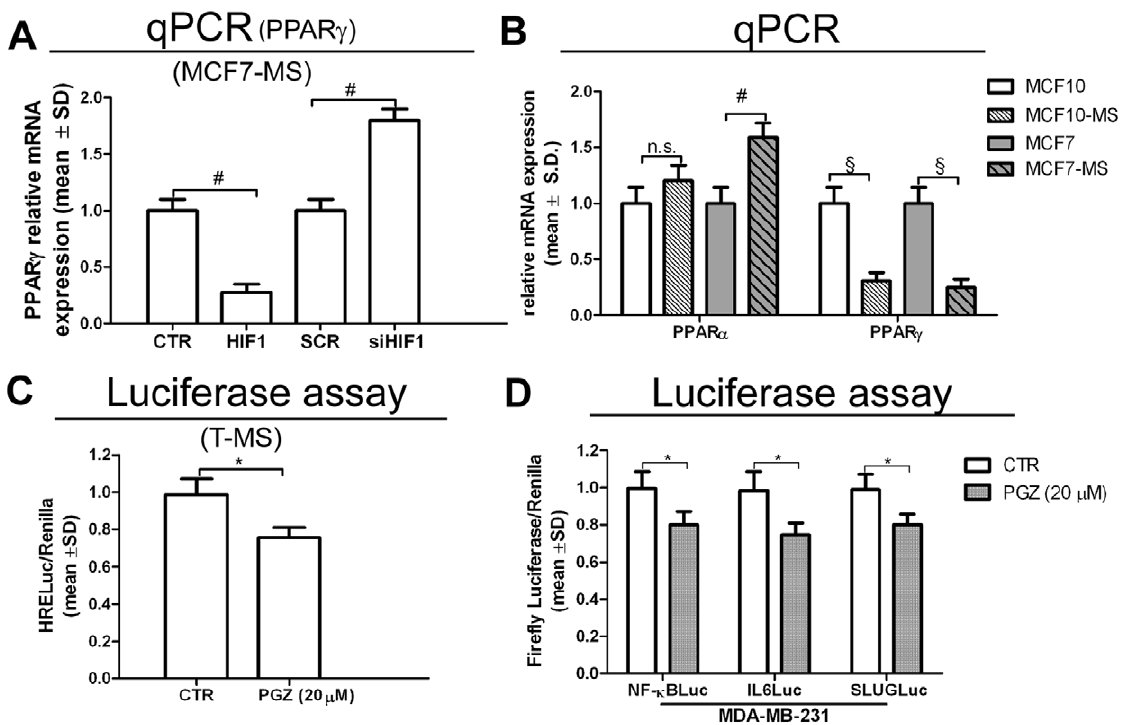
Figure 3. PPAR c antagonizes the PPAR a /HIF1 a interplay and inhibits pro-inflammatory CSCs pathways. (A) PPAR c mRNA qPCR analysis in HIF1 vector (48 h) or SCR/siHIF1 (72 h)-transfected MCF7-MS. (B) PPAR a and PPAR c mRNA qPCR analysis in adherent MCF10 vs MCF10-MS and in adherent MCF7 vs MCF7-MS; (C) HRELuc activity in hypoxic T-MS (samples 15–16) exposed to PPAR c agonist PGZ (20 m M, 24 h) (D) NF- k BLuc, IL6Luc, SLUGLuc activity in MDA-MB-231 breast cancer cells exposed to PGZ (20 m M, 24 h). Data are expressed as mean 6 S.D., n=3, * p , 0.05, # p , 0.01, 1 p , 0.005, ANOVA test. n.s.: not significant.